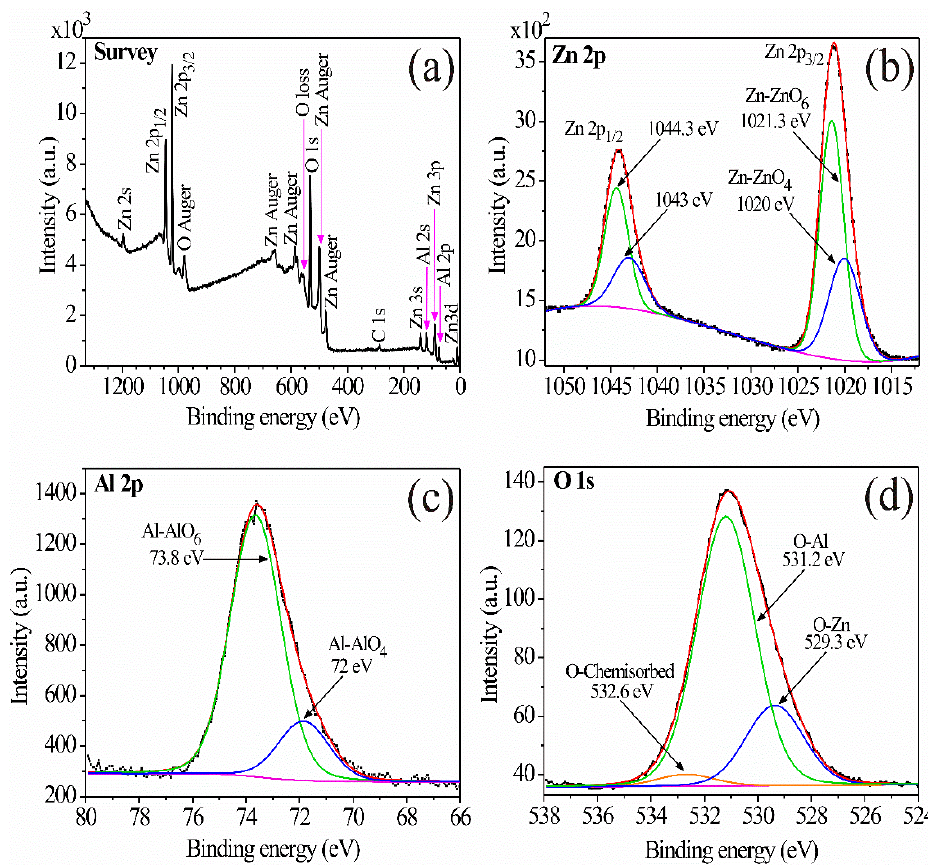
Figure 3 . XPS-spectra: ( a ) survey, ( b ) Zn 2p, ( c ) Al 2p, ( d ) O1s of ZnAl 2 O 4 . The percentage of reflection and the forbidden bandwidth were determined from UV-vis spectra. Figure 4 shows the UV-vis reflectance spectrum of ZnAl 2 O 4 , where an increase in the percentage of reflection from 400 to 700 nm towards infrared and a strong